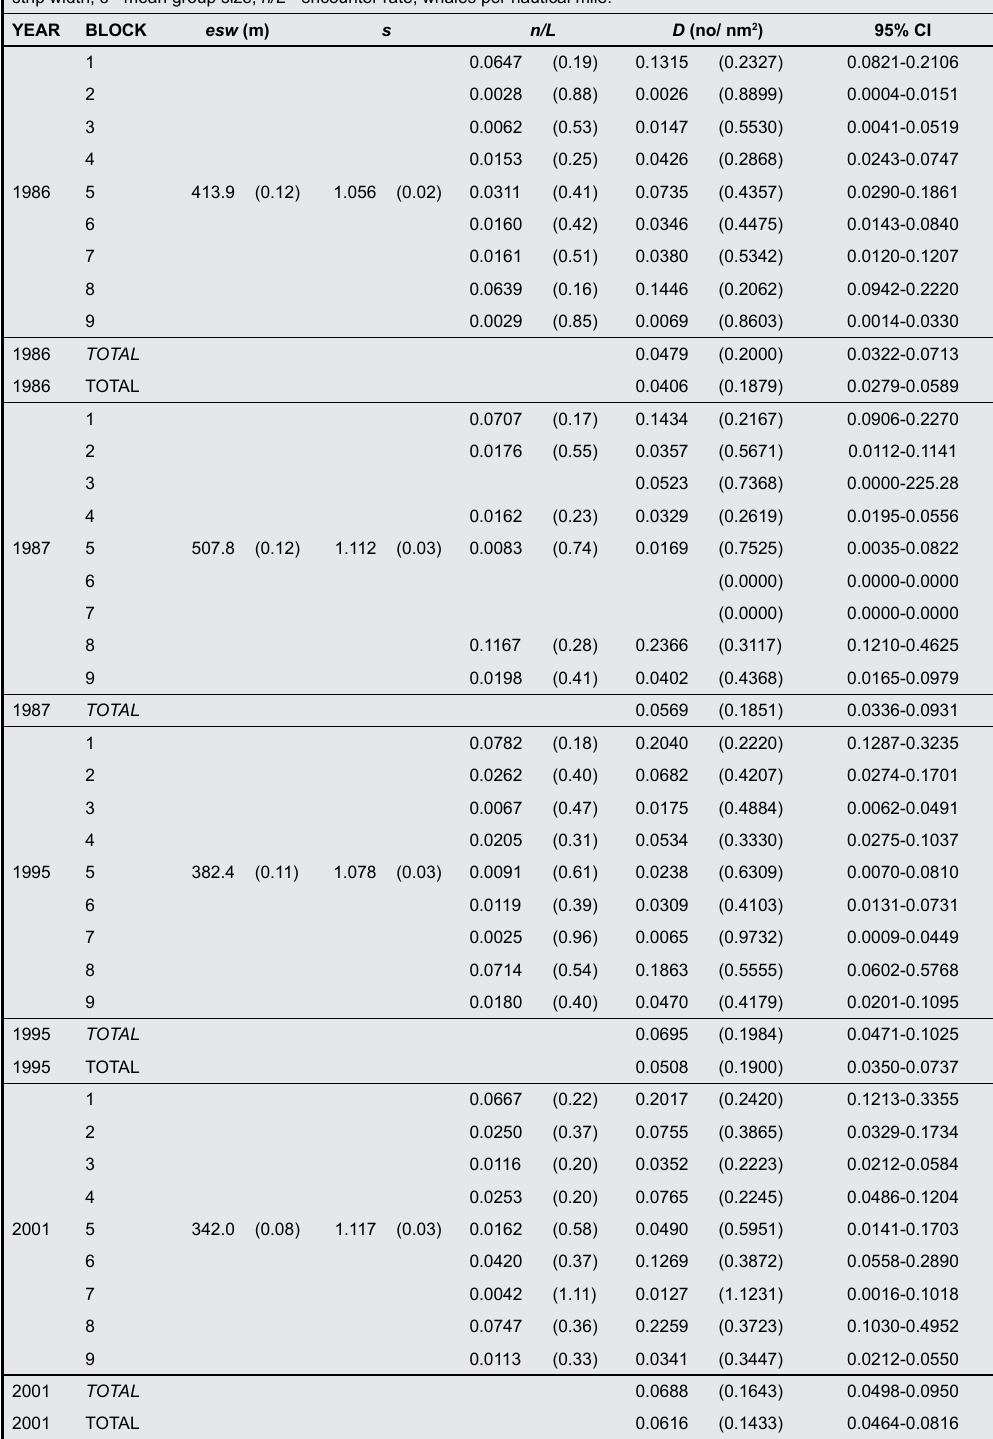
Table 4. Density ( D ) of minke whales from line transect analyses of Icelandic aerial surveys, 1986 to 2001. Coefficients of variation are in parentheses. TOTAL densities and totals in brackets are calculated excluding blocks 3, 6 and 7. esw - effective strip width; s - mean group size; n/L - encounter rate, whales per nautical